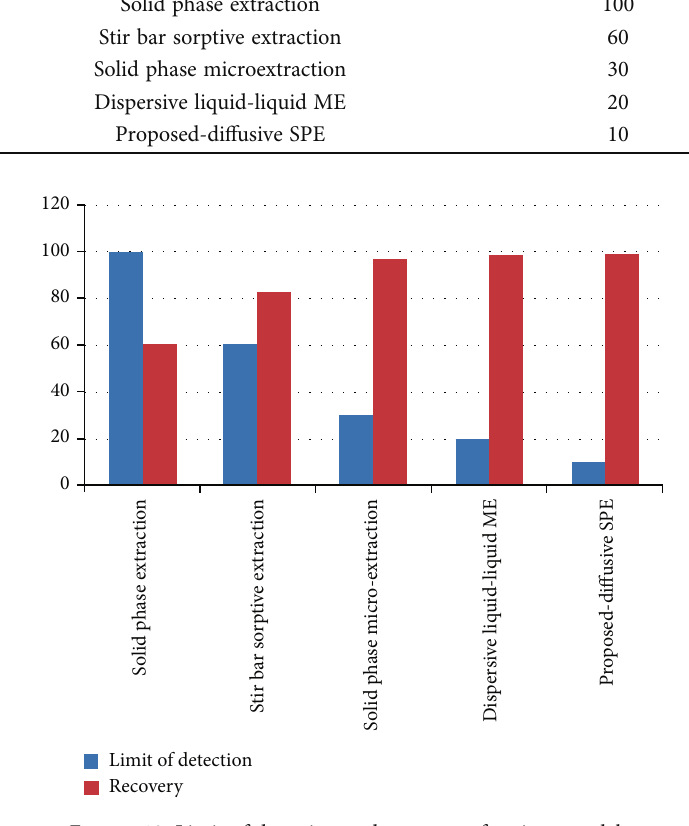
Figure 13: Limit of detection and recovery of various models. Table 3: Veri fi cation outcomes for the provided DSPE method. MA solutions